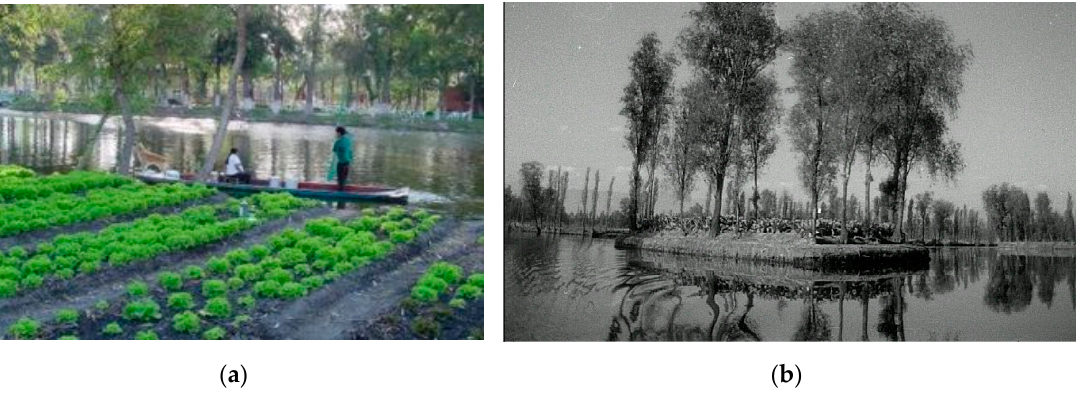
Figure 15. Chinampas: ( a ) View of current plots and ( b ) view of an entire chinampa (http://trabajosnakos22.blogspot.fr/).